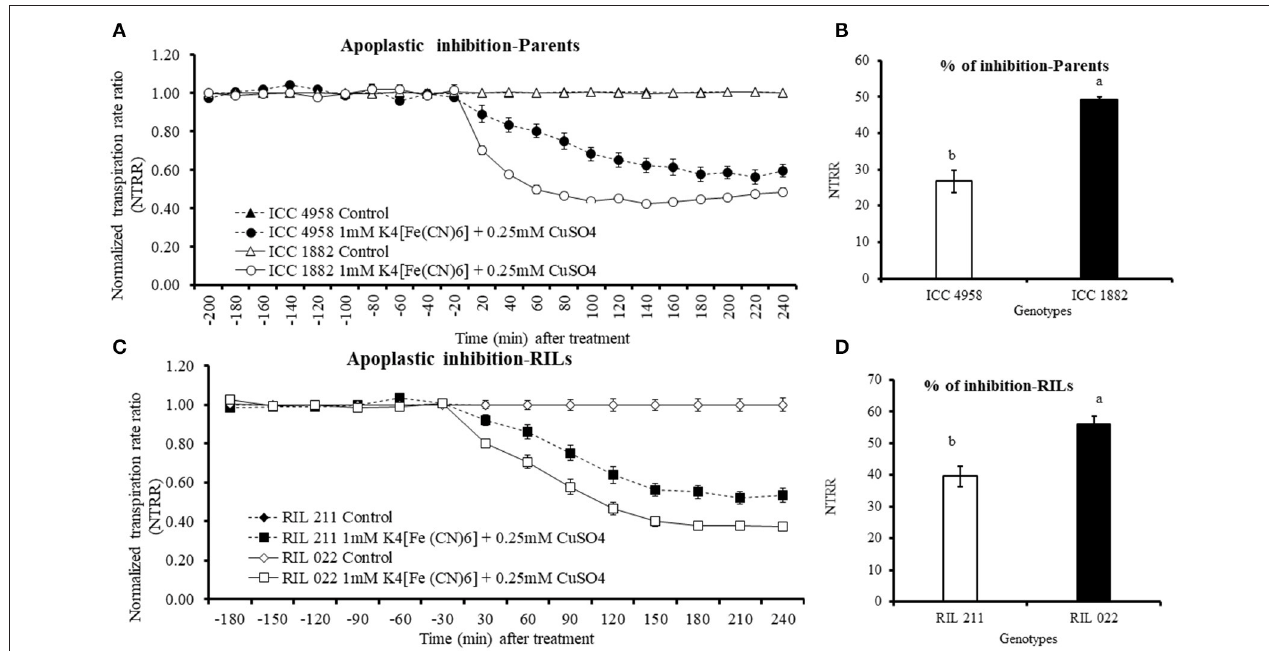
FIGURE 6 | Decline in transpiration rate of four chickpea genotypes contrasting for plant vigor in response to the apoplastic inhibitor [1 mM K 4 [Fe(CN) 6 ] and 0.25 mM- CuSO 4 ]. The dashed lines with round shaped closed symbols represent ICC 4958 and solid line with round shaped open symbols represent ICC 1882 genotype. The solid lines with open square symbols represent RIL 022 and dashed lines with closed square symbols represent RIL 211 genotype. The graph (A) represents apoplastic inhibition of parents and graph (B) represents percentage of apoplastic pathway blocked. The graph (C) represents apoplastic inhibition of progenies (RILs) and graph (D) represents percentage of apoplastic pathway blocked. Each treatment data points represent the NTRR means ( ± SE) of eight replicates per genotype. Bars with different letters are significantly different ( P =